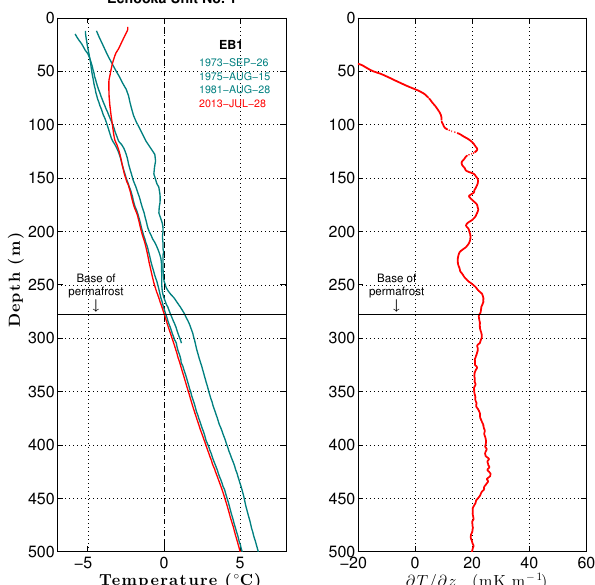
www.earth-syst-sci-data.net Earth Syst. Sci. Data